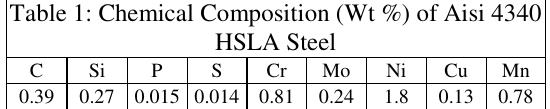
Table 1: Chemical Composition (Wt %) of Aisi 4340 HSLA Steel